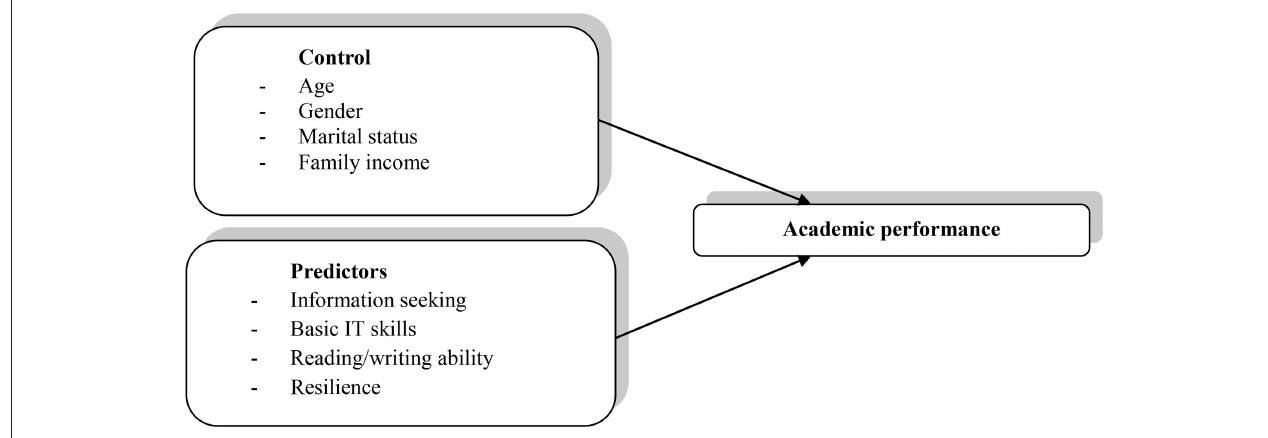
FIGURE 1 | Conceptual model of predictors, control, and dependent